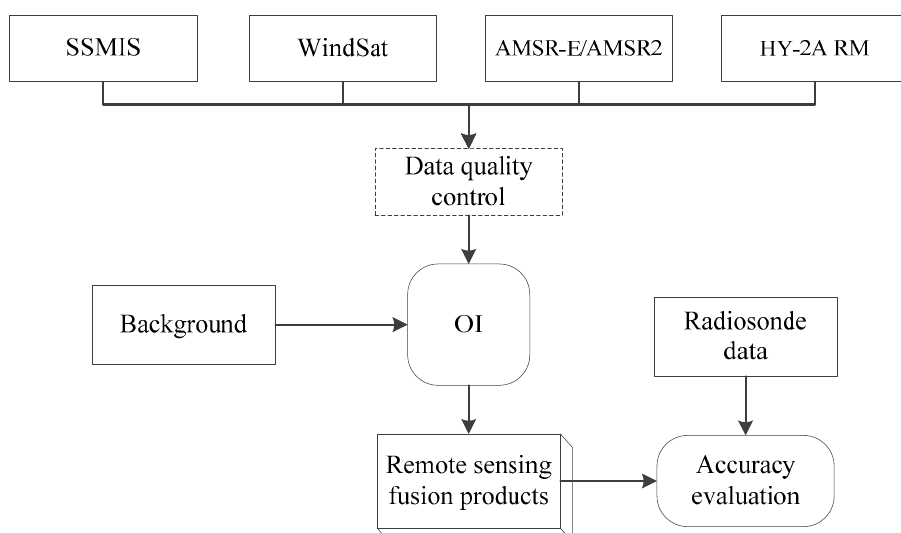
Figure 1. Technical process of the water vapor fusion product.